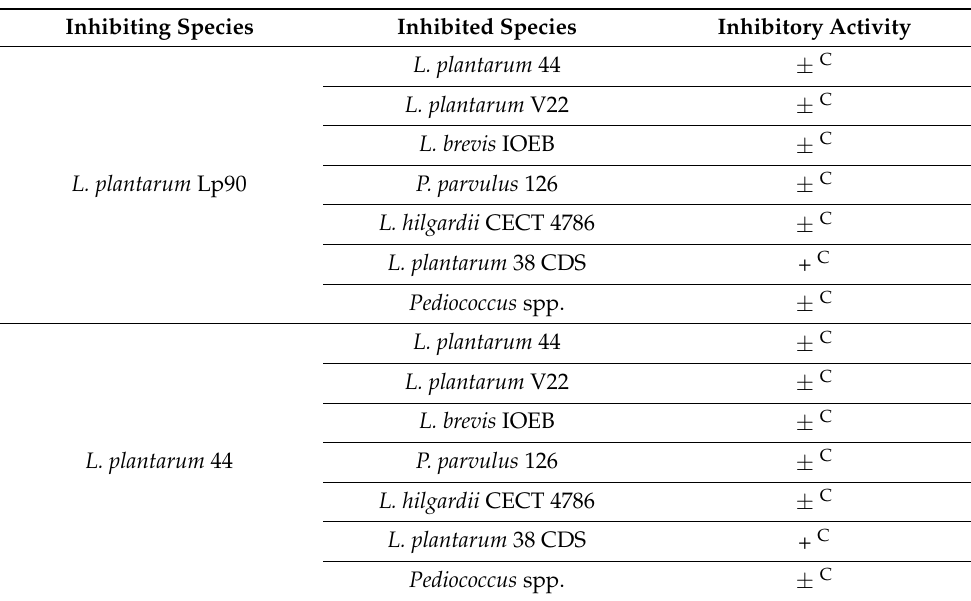
Table 4. Inhibitory activity of lactic bacteria species according to the diameter of halo of inhibition: “ ± ” = lower than 3 mm, “+” = ranging from 3–6 mm and “++” = more than 6 mm. Inhibiting